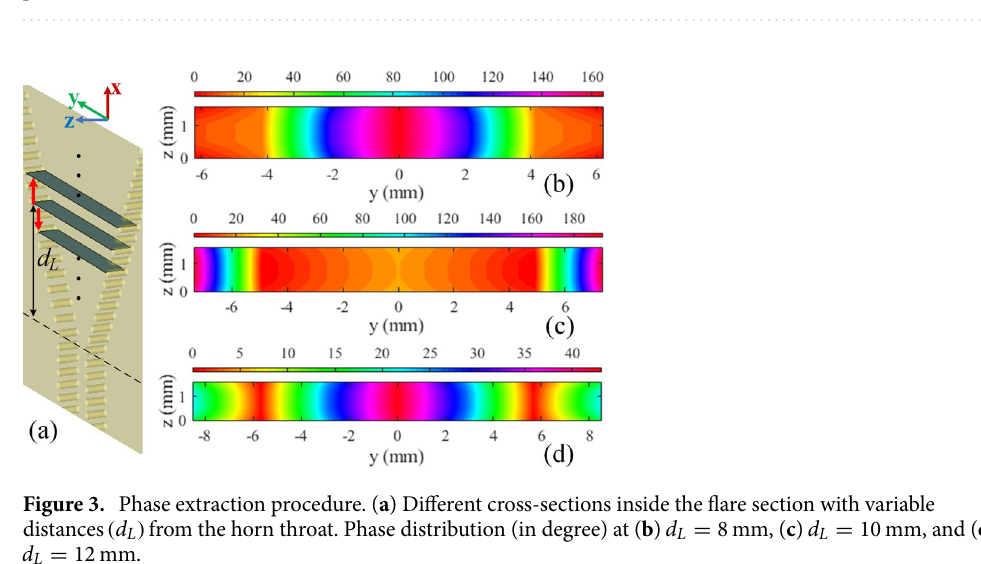
Figure 2. Conventional SIW H-plane horn antenna. ( a ) The geometry, ( b ) the simulated |E-field| distribution pattern at 30 GHz.